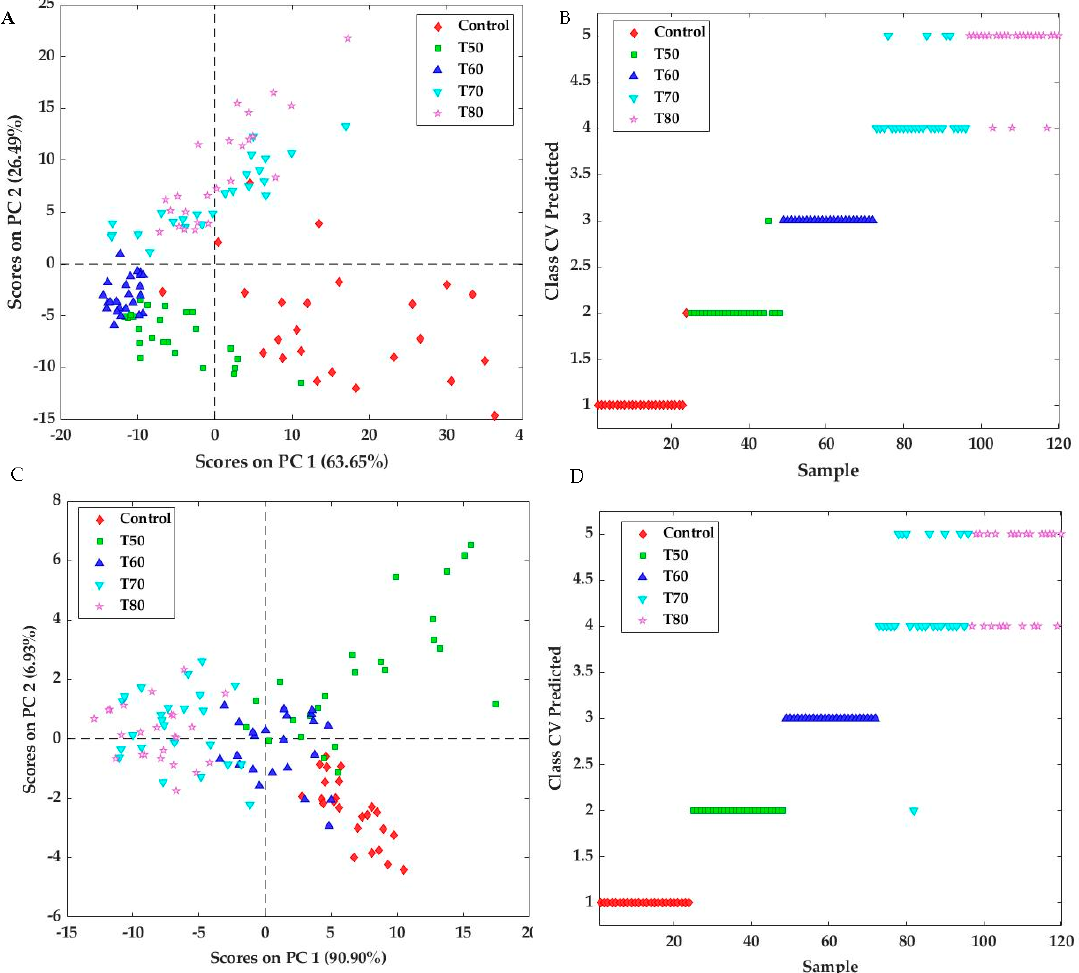
Figure 5. Principal Components Analysis (PCA) ( A , C ) and predicted cross-validated classes resulted from Support Vector Machine Classification (SVMC) analysis ( B , D ) applied respectively to the fluorescence (A-B) and the diffuse reflectance (C-D) data, obtained on the control and heat treated cod samples as a function of cooking temperatures (T50, T60, T70, T80).